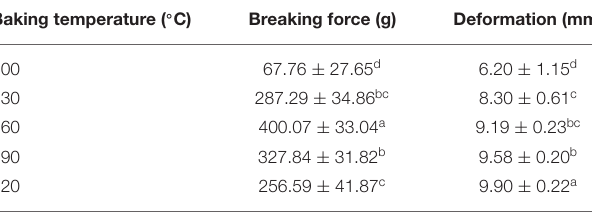
TABLE 1 | Effect of baking temperature on the gel strength of eel